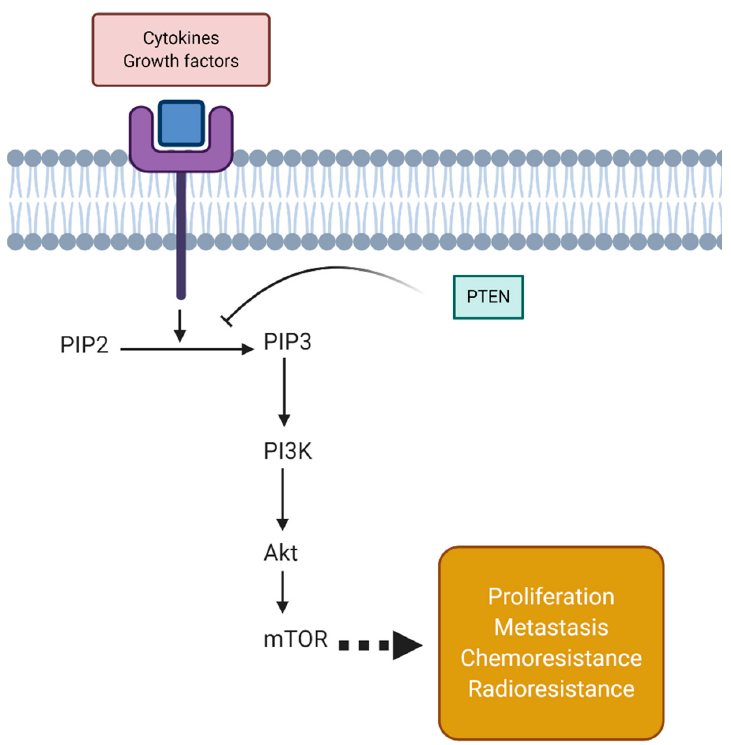
Figure 1. An overview of phosphatase and tensin homolog (PTEN) signaling. The cytokines and growth factors can induce the transformation of phosphatidylinositol-4,5-bisphosphate (PIP2) to phosphatidylinositol3,4,5-triphosphate (PIP3) by binding to a related receptor. Then, PI3K stimulates protein kinase B (Akt)/mammalian target of rapamycin (mTOR) sig- naling to induce the expression of genes involved in cancer progression, chemoresistance, and radioresistance. PTEN as a tumor-suppressing factor prevents PIP2 transformation to PIP3, restricting cancer